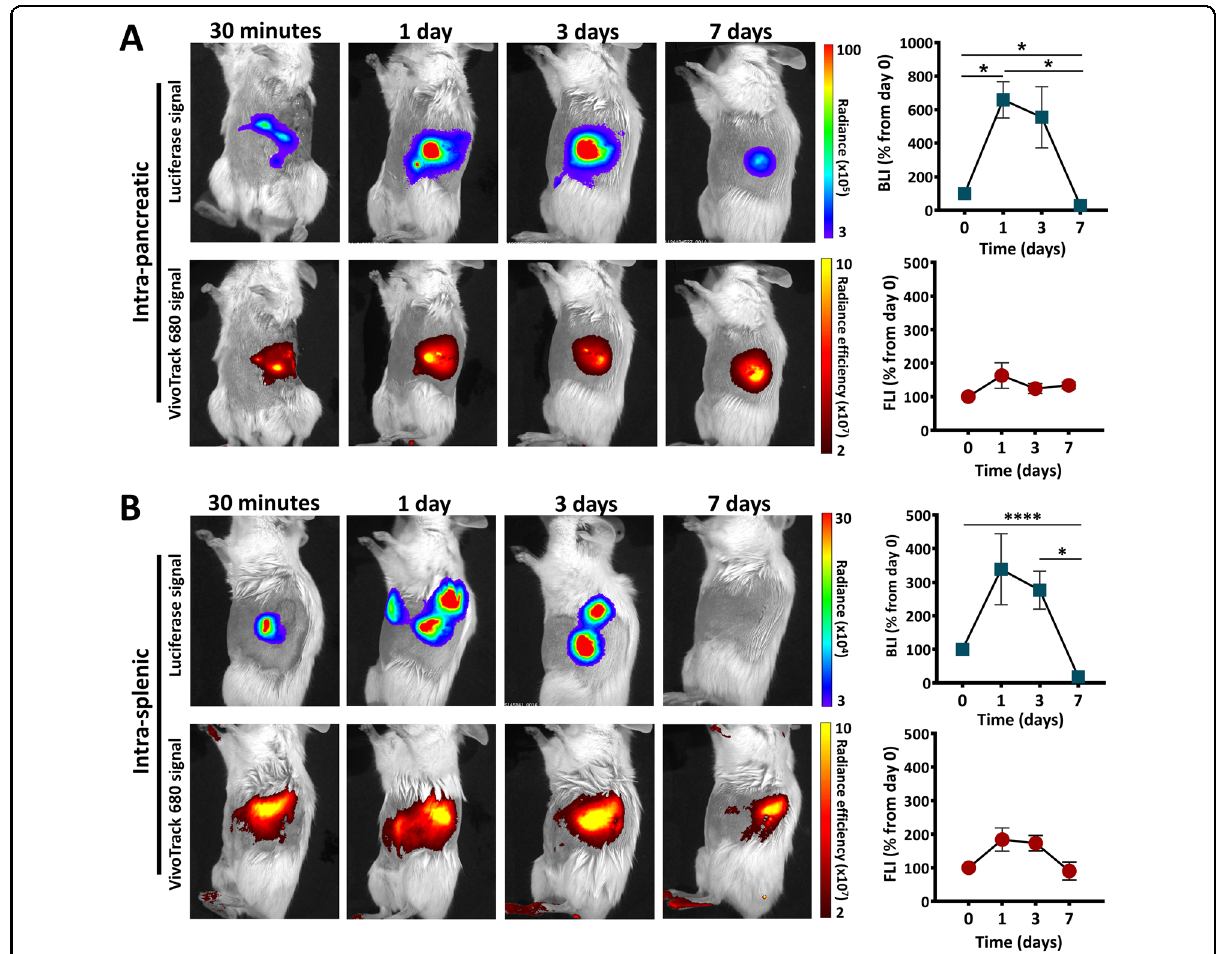
Fig. 2 Biodistribution of MSC after intrapancreatic or intrasplenic transplantation in pre-diabetic NOD females. BLI and FLI time-course images of a representative mouse transplanted with Luc + VT680 + MSC into the pancreas ( A ) and spleen ( B ). The diagrams on the right illustrate the quantitative data from all mice within each group ( n = 5 – 6 per group). Data are plotted as mean ± SEM (* p < 0.05, one-way ANOVA followed by Tukey ’ s